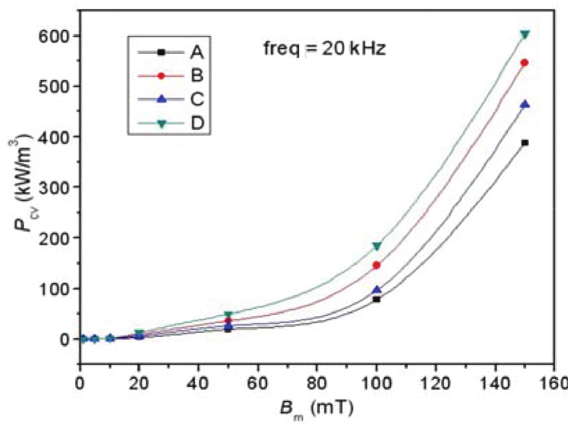
Figure 5: The relationship between power loss ( P cv ) and flux density ( B m ) at